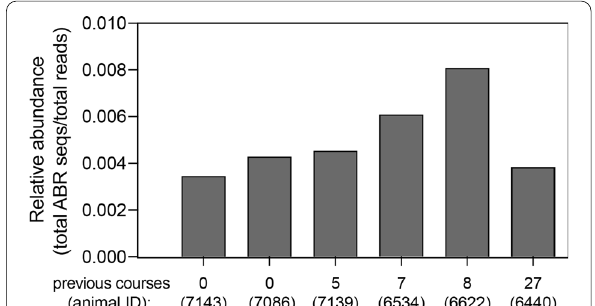
Fig. 6 Relative abundance of antibiotic resistance (ABR) genes in six healthy, male ring‑tailed lemurs ( Lemur catta ) that had received different numbers of treatment courses of antibiotics across their